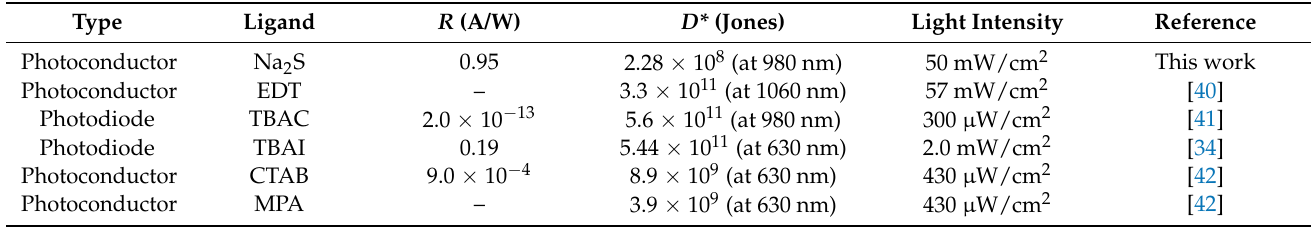
Table 2. Summary of the performance of PbS quantum dot photodevices.